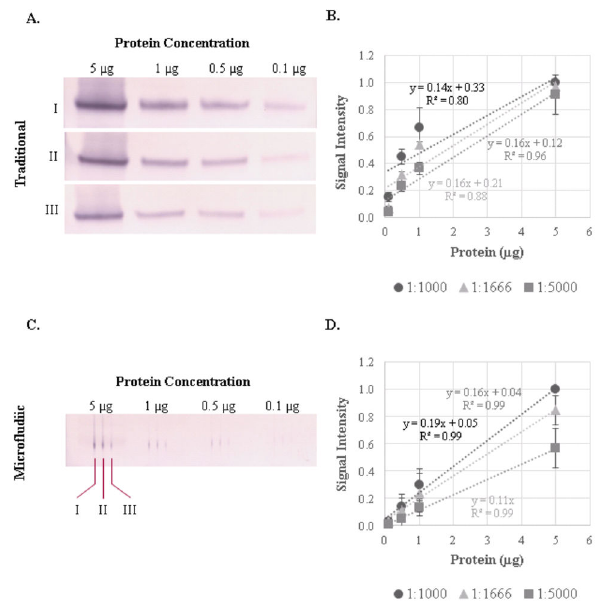
Figure 2. Comparison of traditional and microfluidic immunoblotting in human blood monocyte samples. Representative immunoblots for RelA/p65 at four protein concentrations (5, 1, 0.5 and 0.1 µg) and three antibody dilutions (I: 1:1000; II: 1:1666; III: 1:5000) using (A) traditional and (B) microfluidic immunoblotting techniques. The signal intensity for the (C) traditional and (D) microfluidic blots were quantified using ImageJ software and normalized to the signal associated with 5 µg of protein probed with the 1:1000 p65 antibody dilution. Immunoblots are representative of three independent PVDF membranes from the same PBMC